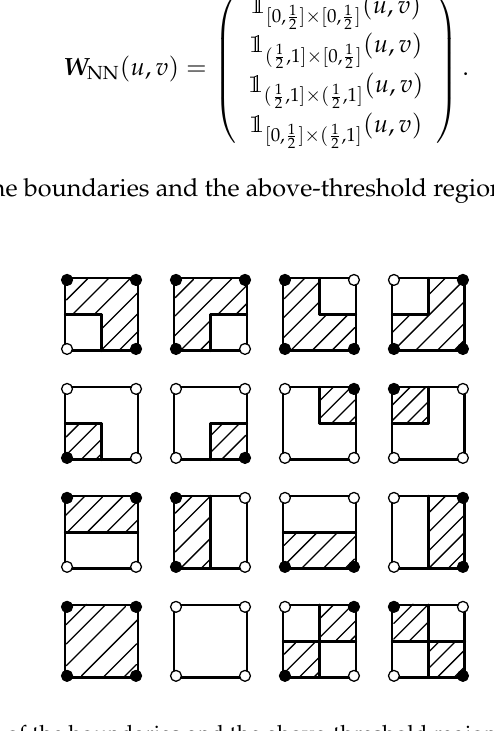
Figure 7. Illustrations of the boundaries and the above-threshold regions with the NN